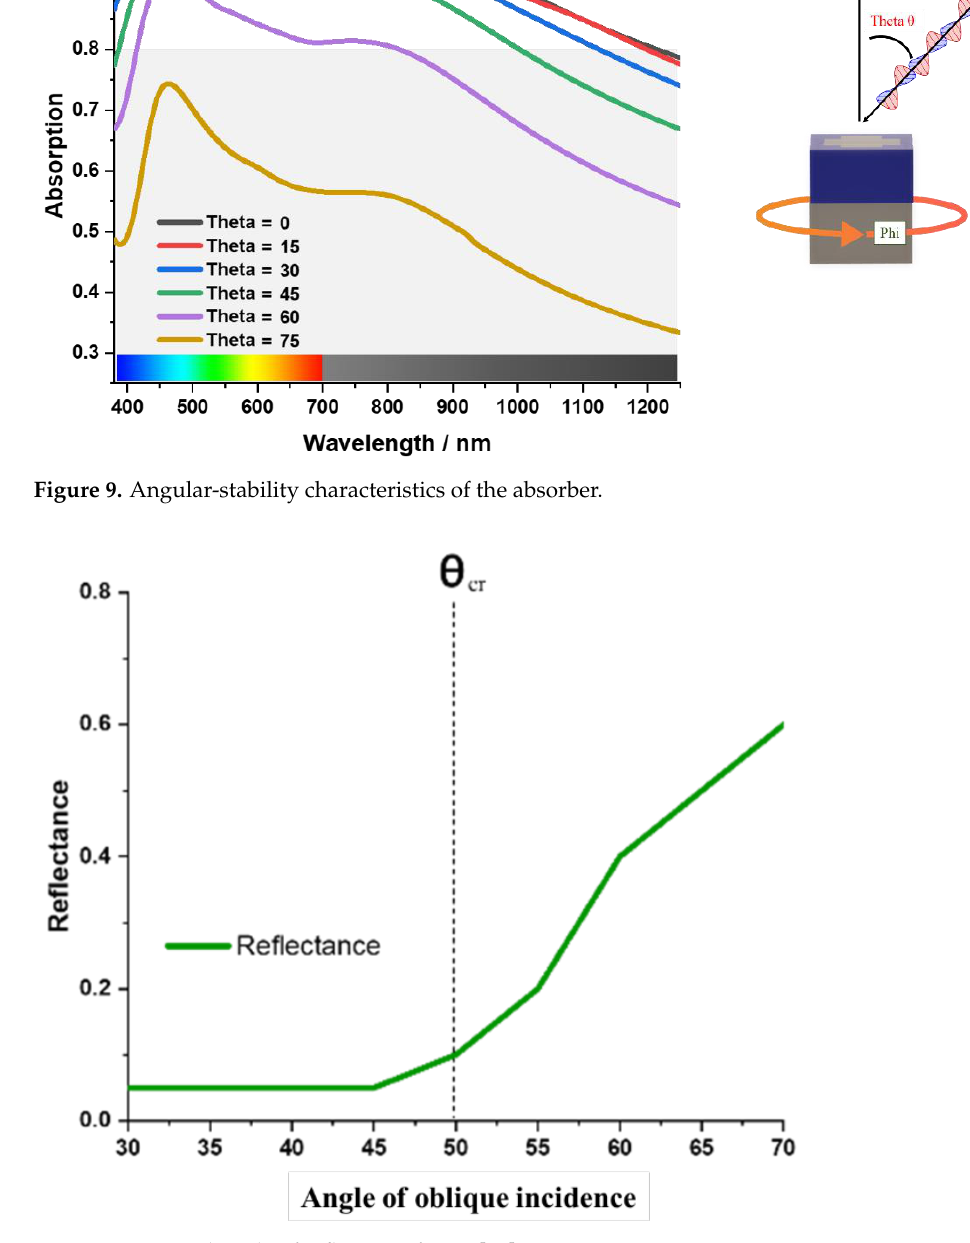
Figure 10. Critical angle of reflection of SiO 2 [36].